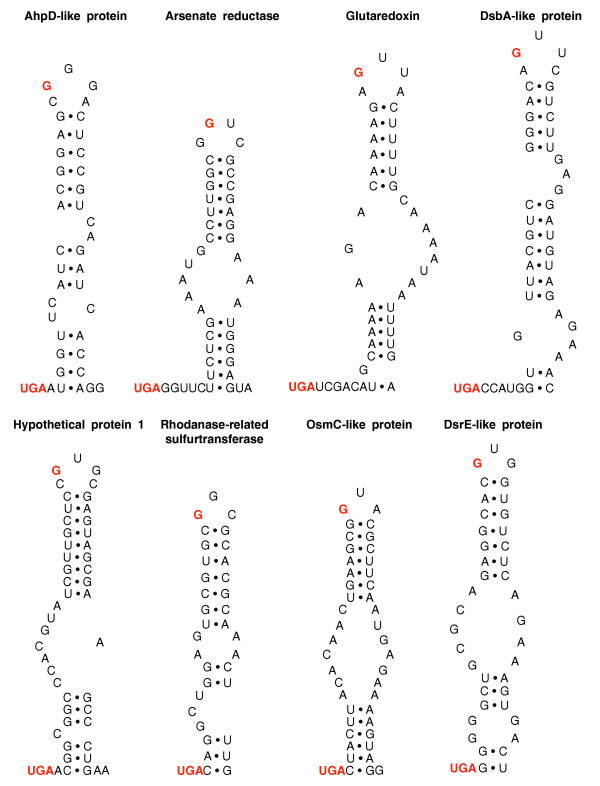
Predicted bacterial SECIS elements in representative sequences of some new selenoprotein families. Only sequences downstream of in-frame UGA codons are shown. In-frame UGA codons and conserved guanosines in the apical loop are shown in red. AhpD-like protein, AACY01418594; Arsenate reductase, AACY01238341; Glutaredoxin, AACY01002222; DsbA-like protein, AACY01178397; Hypothetical protein 1, AACY01574522; Rhodanase-related sulfurtransferase, AACY01016424; OsmC-like protein, AACY01145085; DsrE-like protein, AACY01486889.